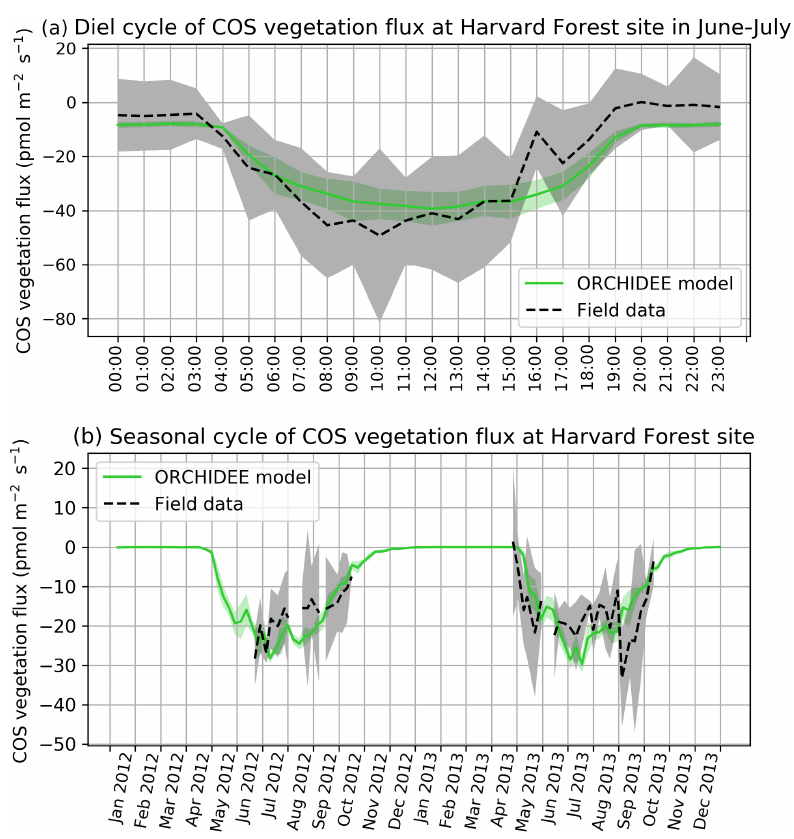
Figure 1. (a) Mean diel cycle of observed vegetation COS flux (Wehr et al., 2017) and modelled COS vegetation flux in June and July 2012 and 2013, at Harvard Forest, using an atmospheric convention where an uptake of COS by the ecosystem is negative. The shaded areas above and below each curve represent 1 standard deviation of the considered hourly values over the June–July period. (b) Mean seasonal cycle of simulated and observed weekly average vegetation COS flux in 2012 and 2013, at Harvard Forest. The shaded areas above and below each curve represent 1 standard deviation of the daily means within the considered week. We imposed the condition of having observations on at least 2 different days to compute the corresponding weekly